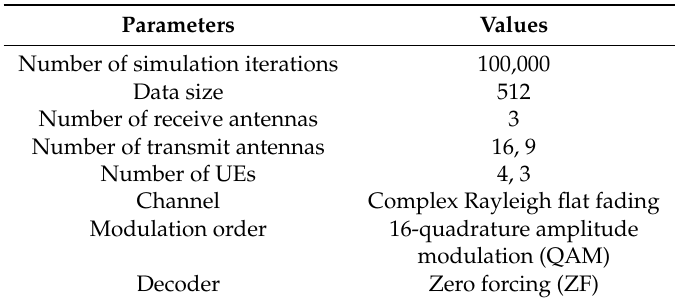
Table 1. The simulation